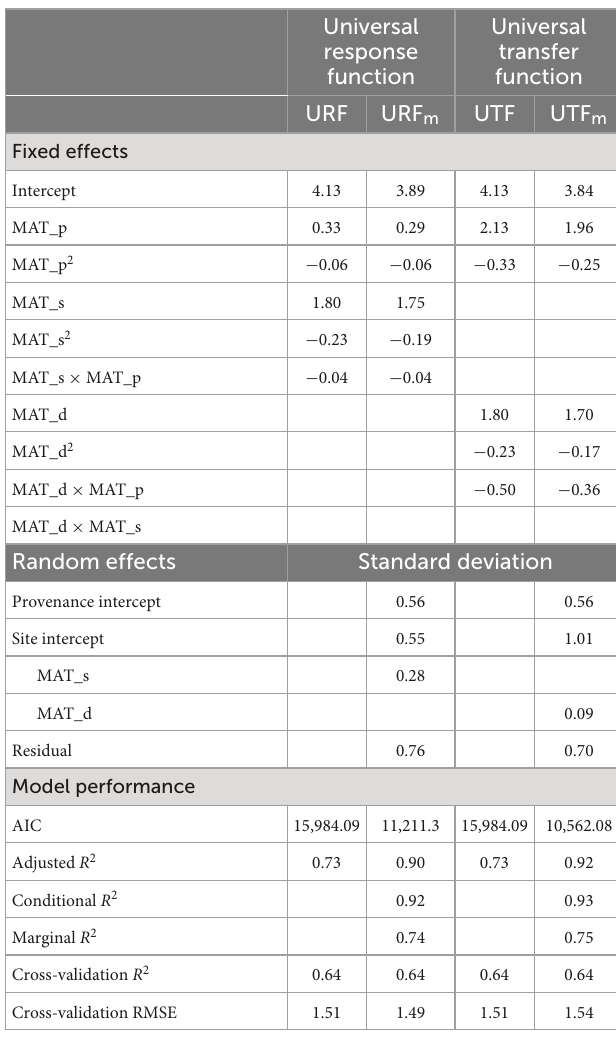
TABLE 1 Parameter estimates and model performance statistics for universal response function (URF), universal transfer functions (UTF), and their mixed-effect models (URF m and UTF m ) with a single climate variable, mean annual temperature for test site (MAT_s), provenance (MAT_p), and transfer distance (MAT_d = MAT_s −